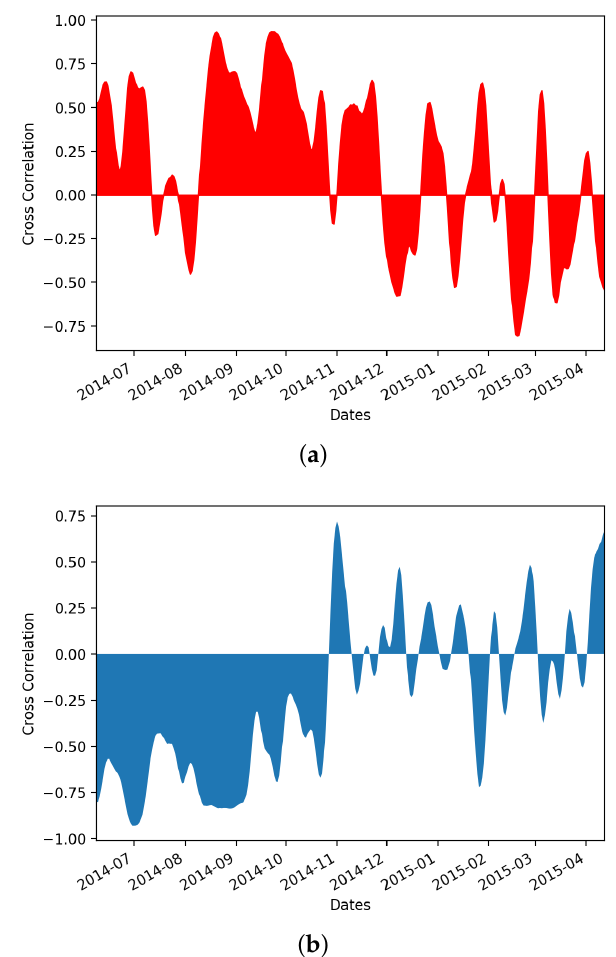
Figure 5. ( a ) Cross-correlation between the wind stress curl and the cyclone of the Ras al Hadd dipole with days starting in April 2014; ( b ) same as ( a ) for the correlation of the wind with the anticyclone of the dipole.